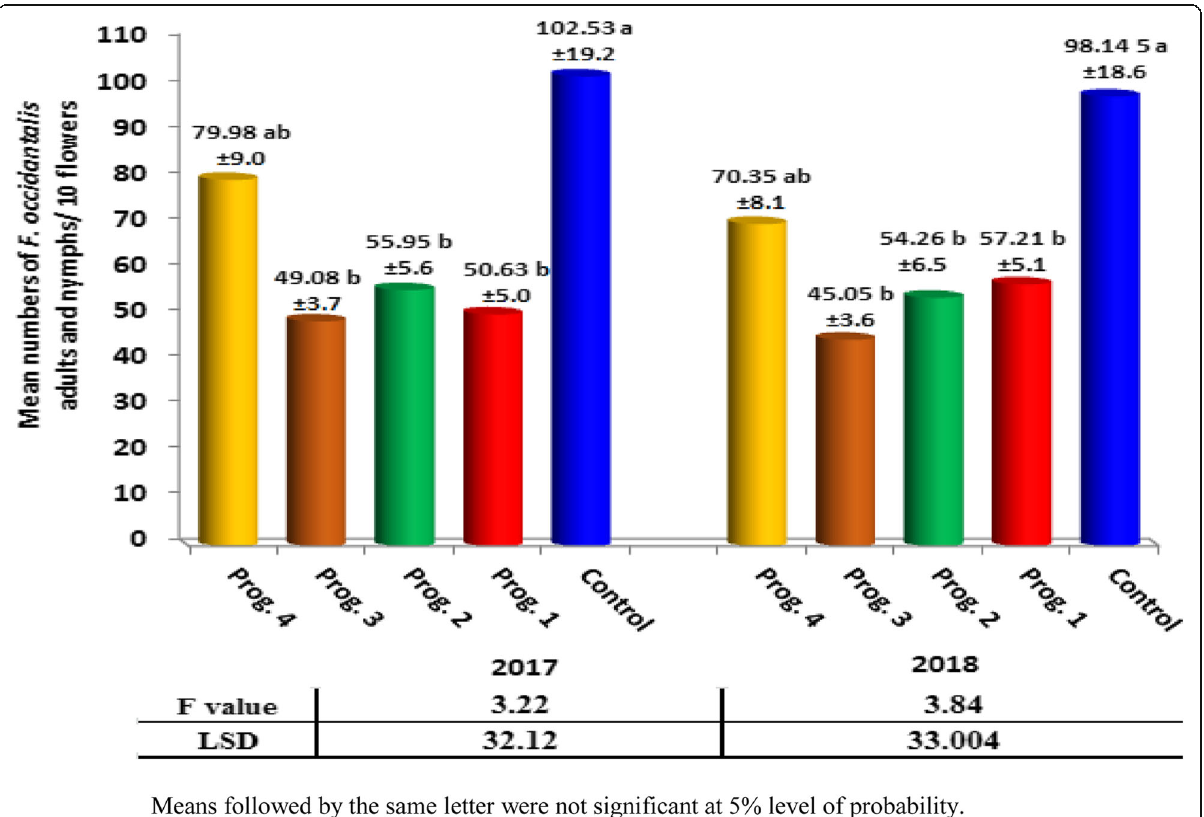
Fig. 2 Implement of Frankliniella occidentalis managing by sequentially four insecticide programs in pepper